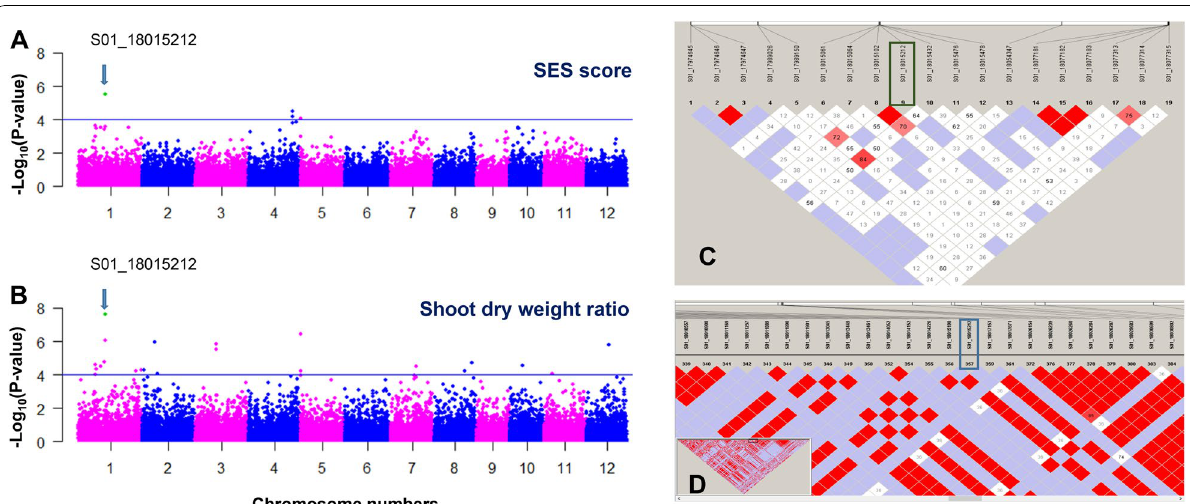
Fig. 5 GWAS of salinity responses with SES scores and shoot dry weights for the MDI accessions. A Manhattan plot for SES scores with 29,881 imputed SNPs (Tam et al. 2019) from the 79 accessions at 20 DUT with 100 mM NaCl. B Manhattan plot for shoot dry weight ratio. Both analyses identified a single and identical SNP peak, S01_18015212, on chromosome 1. C Linkage disequilibrium (LD) analysis showing that S01_18015212 forms a single block using 19 SNPs within 200 kb obtained by RAD-seq analysis for the 79 accessions. D LD analysis using 657 SNPs from the 20 accessions, showing a single LD block within the 200-kb